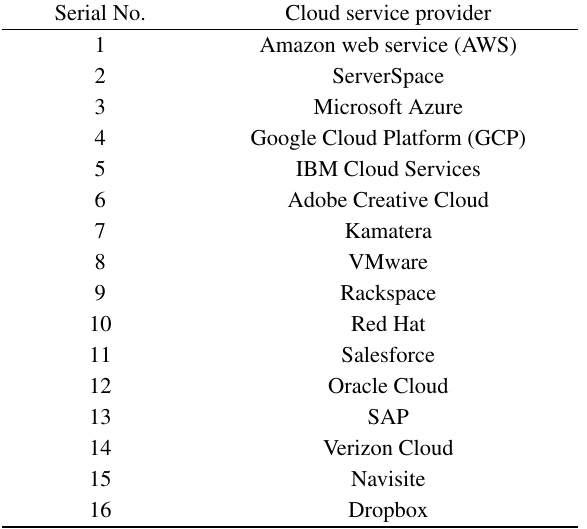
Fig. 1 Design of cloud-based software development life cycle (SDLC). Table 1 Major service providers in the global market of cloud. Serial